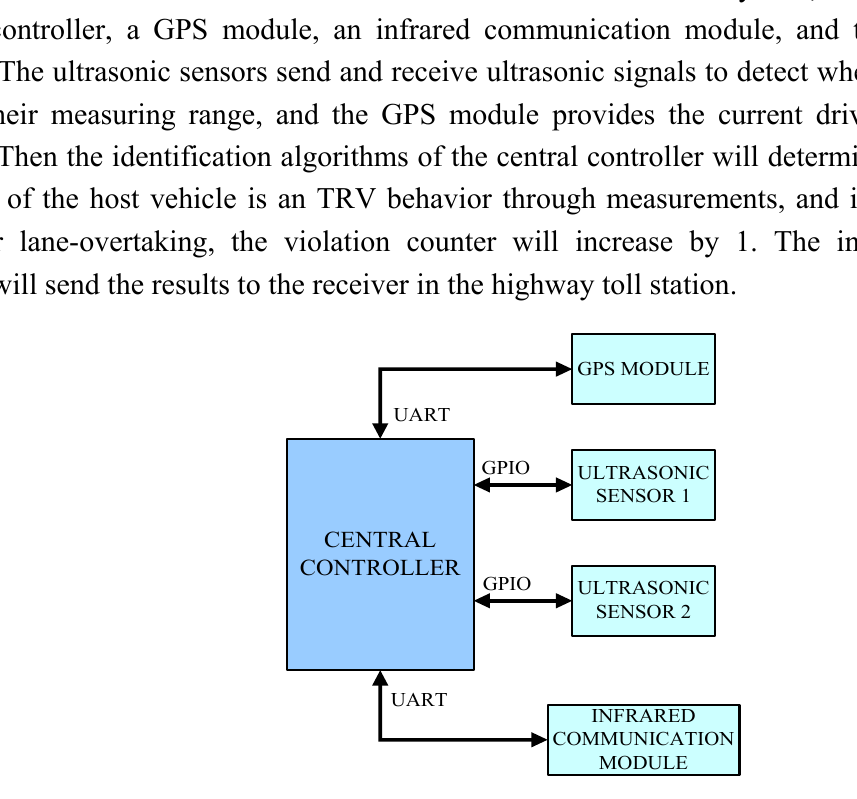
Figure 2. The hardware configuration of the ultrasonic sensor